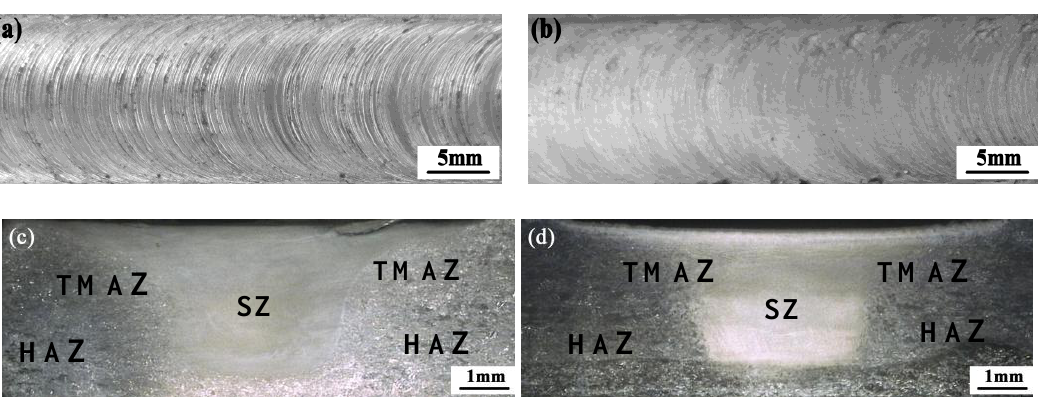
Figure 2. Top surface morphology ( a ) in air and ( b ) underwater, and macro-structures of the cross-section ( c ) in air and ( d ) underwater of the FSP